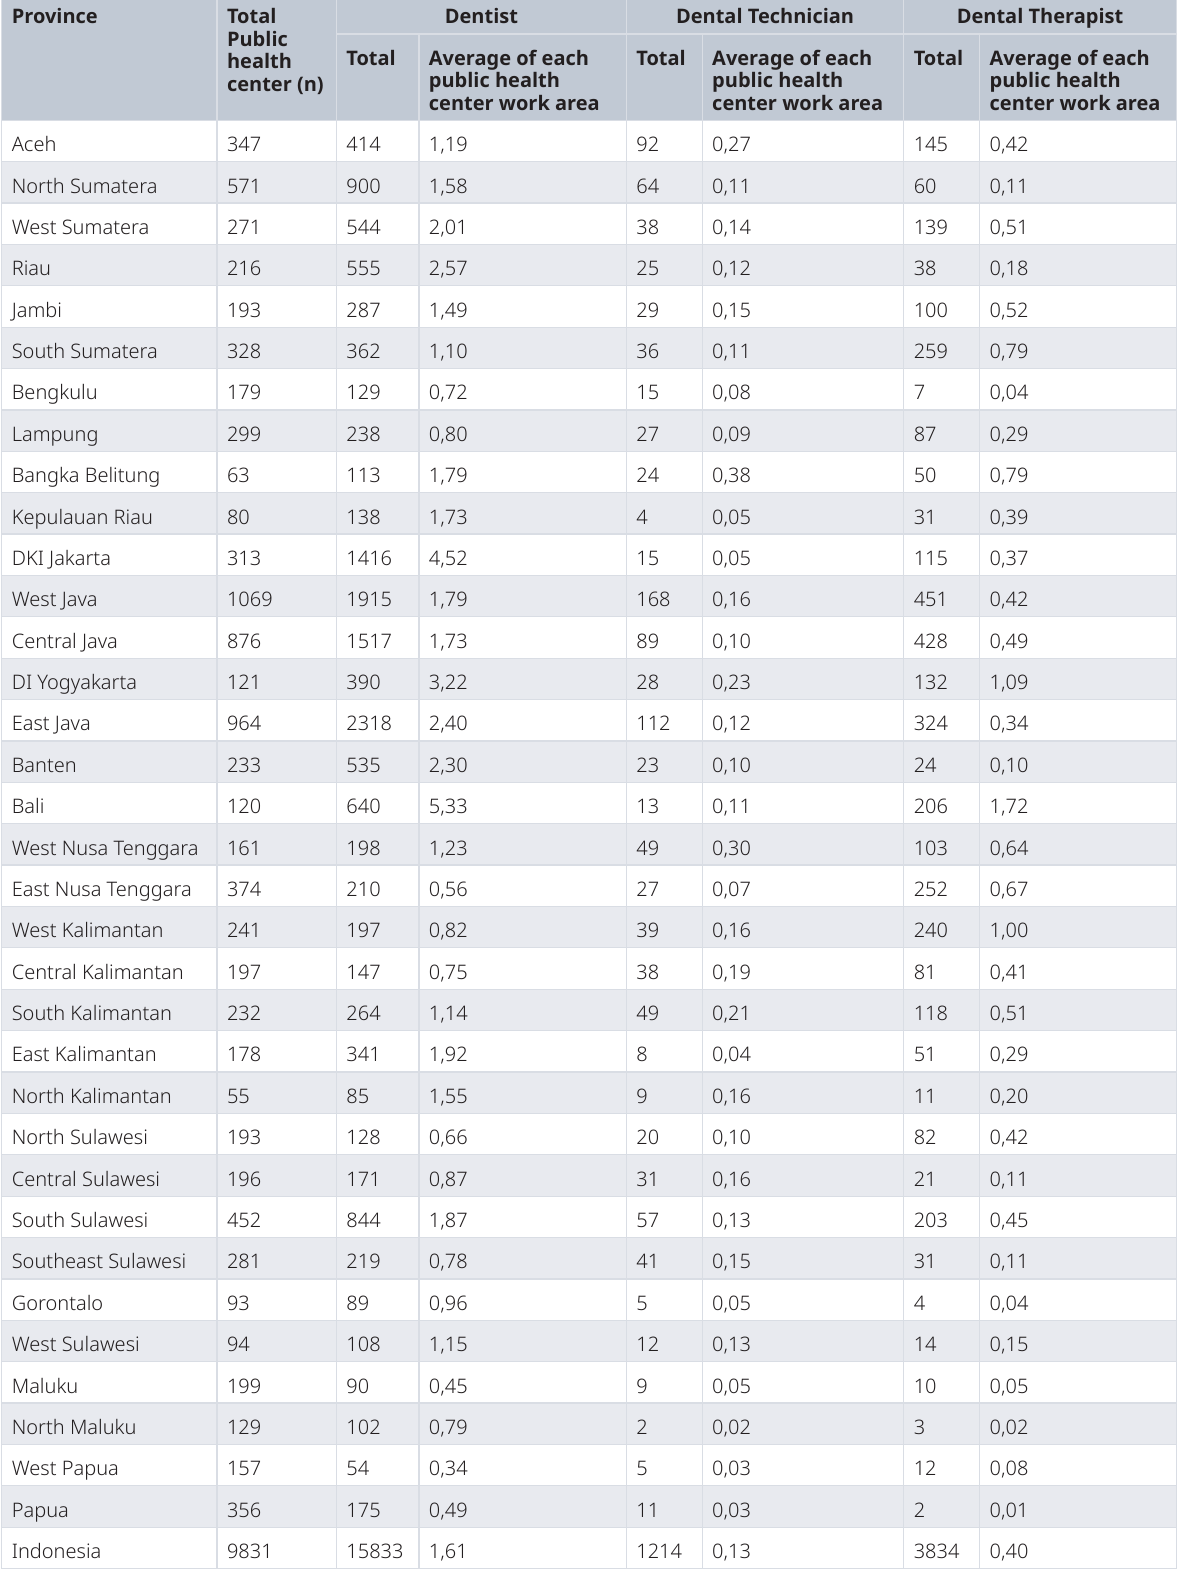
Table 1. Distribution of dental personnel in each province in Indonesia.